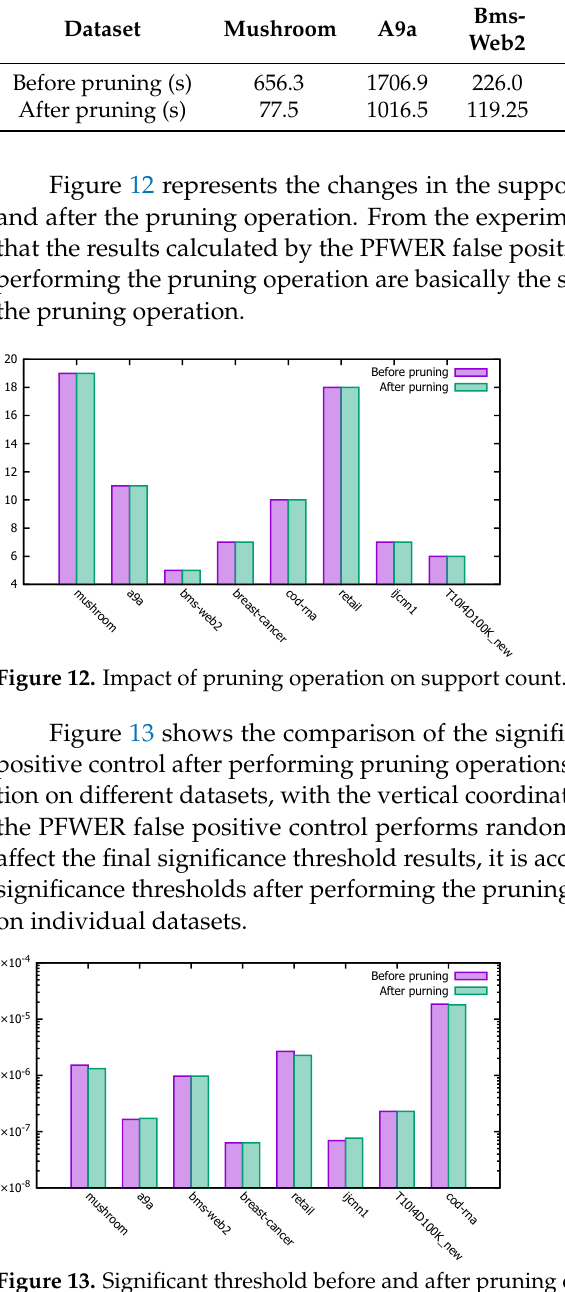
Figure 13. Significant threshold before and after pruning